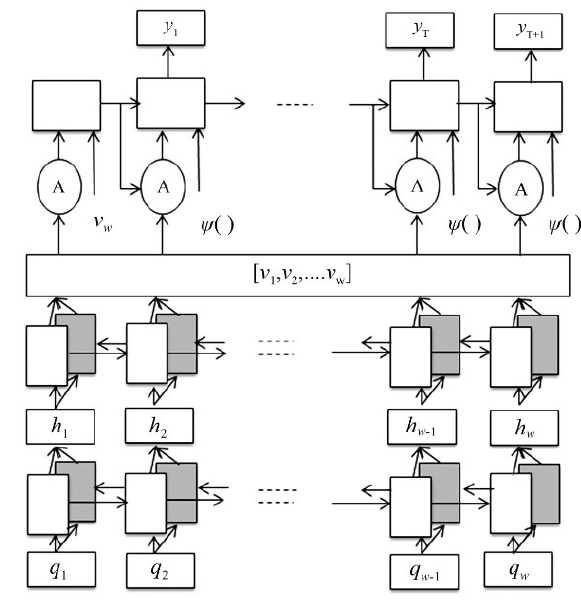
Fig. 2 Text recognition